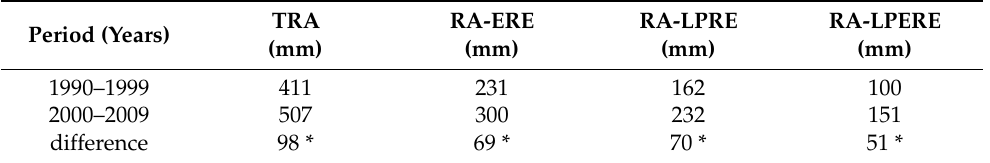
Table 1. The summer TRA, RA-ERE, RA-LPRE, and RA-LPERE over the HRB for the periods 1990–1999, 2000–2009, and the associated differences between the two periods. The superscript “*” indicates that the differences are statistically significant at the 90% confidence level.